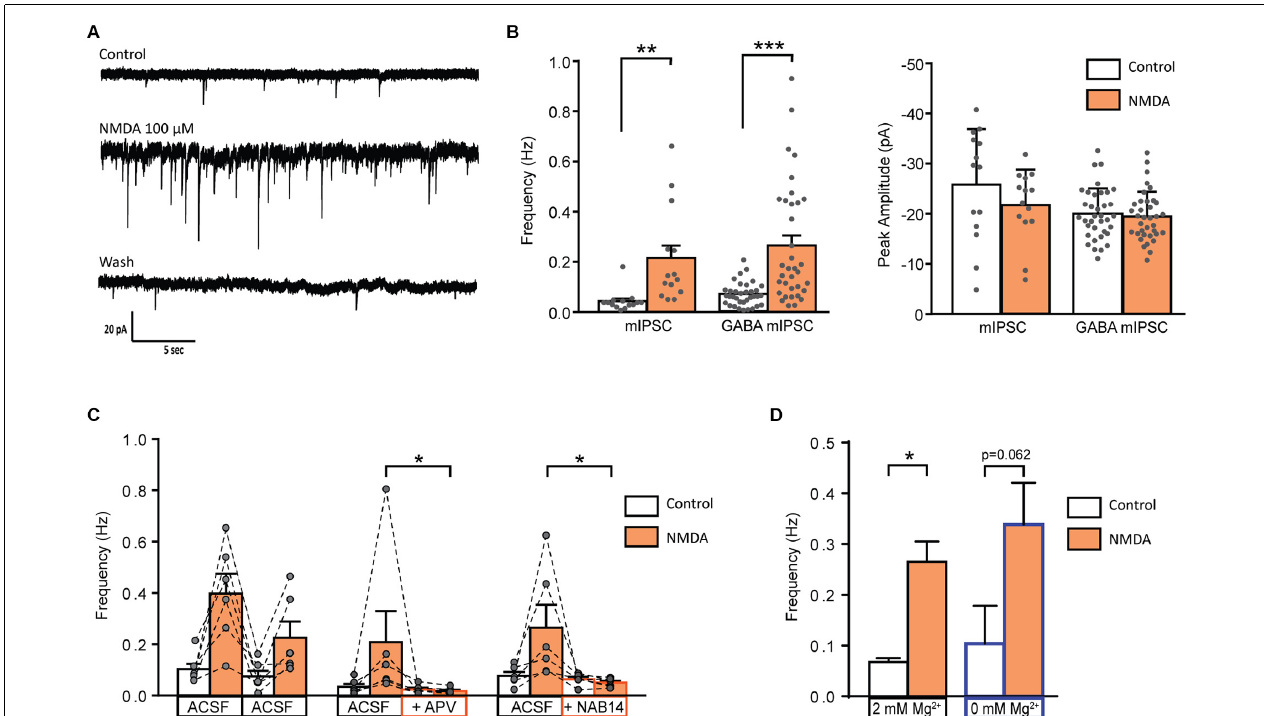
FIGURE 3 | Activation of GluN2C/D containing NMDA receptor increase miniature GABAergic IPSCs. (A) Representative traces of mIPSCs recorded from a lamina II neuron in spinal cord slice from C57Bl6 mouse before (Control) during NMDA application (NMDA; 100 s after the beginning of application) and after a washout (wash; 400 s after the beginning of NMDA washout). (B) Bar graph showing total mIPSC ( N = 14) and GABA mIPSC ( N = 36) frequency and peak amplitude before (Control) and during NMDA application (NMDA). (C) Effect of APV (50 µ M, N = 6) and NAB 14 (10 µ M, N = 5) on NMDA-induced increase in GABA